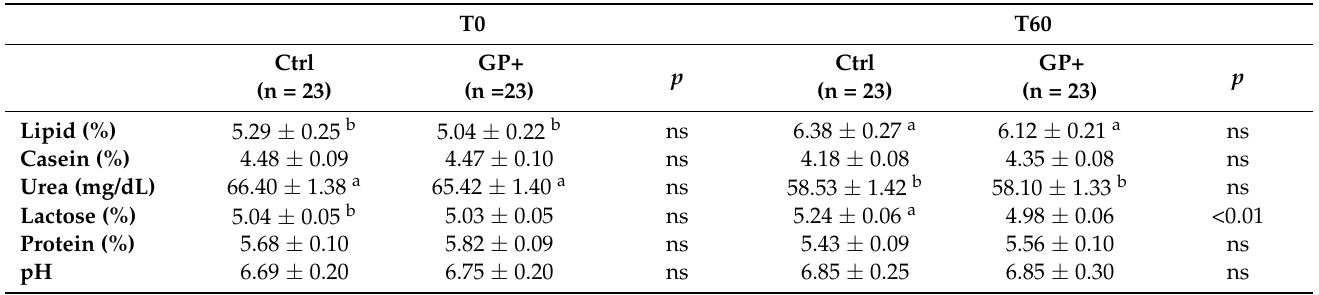
Data are reported as mean ± SE. a,b Means in the same row with different uppercase superscript letters are significantly different by time ( p < 0.05). ns = not significant ( p > 0.05). The TPCs and AOA in ewes’ milk were not affected by the diet (Figure 1). No significant